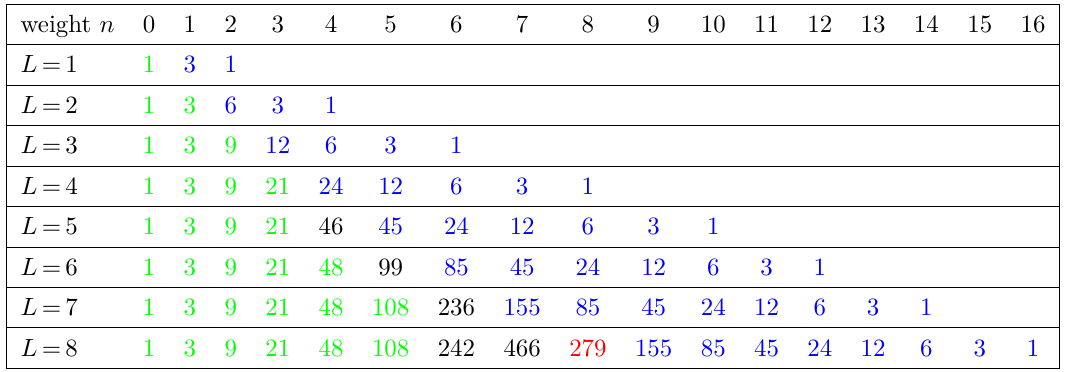
Table 2. The number of independent { n, 1 , 1 , . . . , 1 } coproducts of the form factor E ( L ) through L = 8 loops, at symbol level . A green number denotes saturation of the space C constructed from the bottom up. A blue number denotes saturation of the space of coproducts, as indicated by the ( L, n ) number being the same as the ( L + 1 , n + 2) number. A red number means it is almost certainly saturated, but we do not have the evidence of two successive loop orders to “prove” it